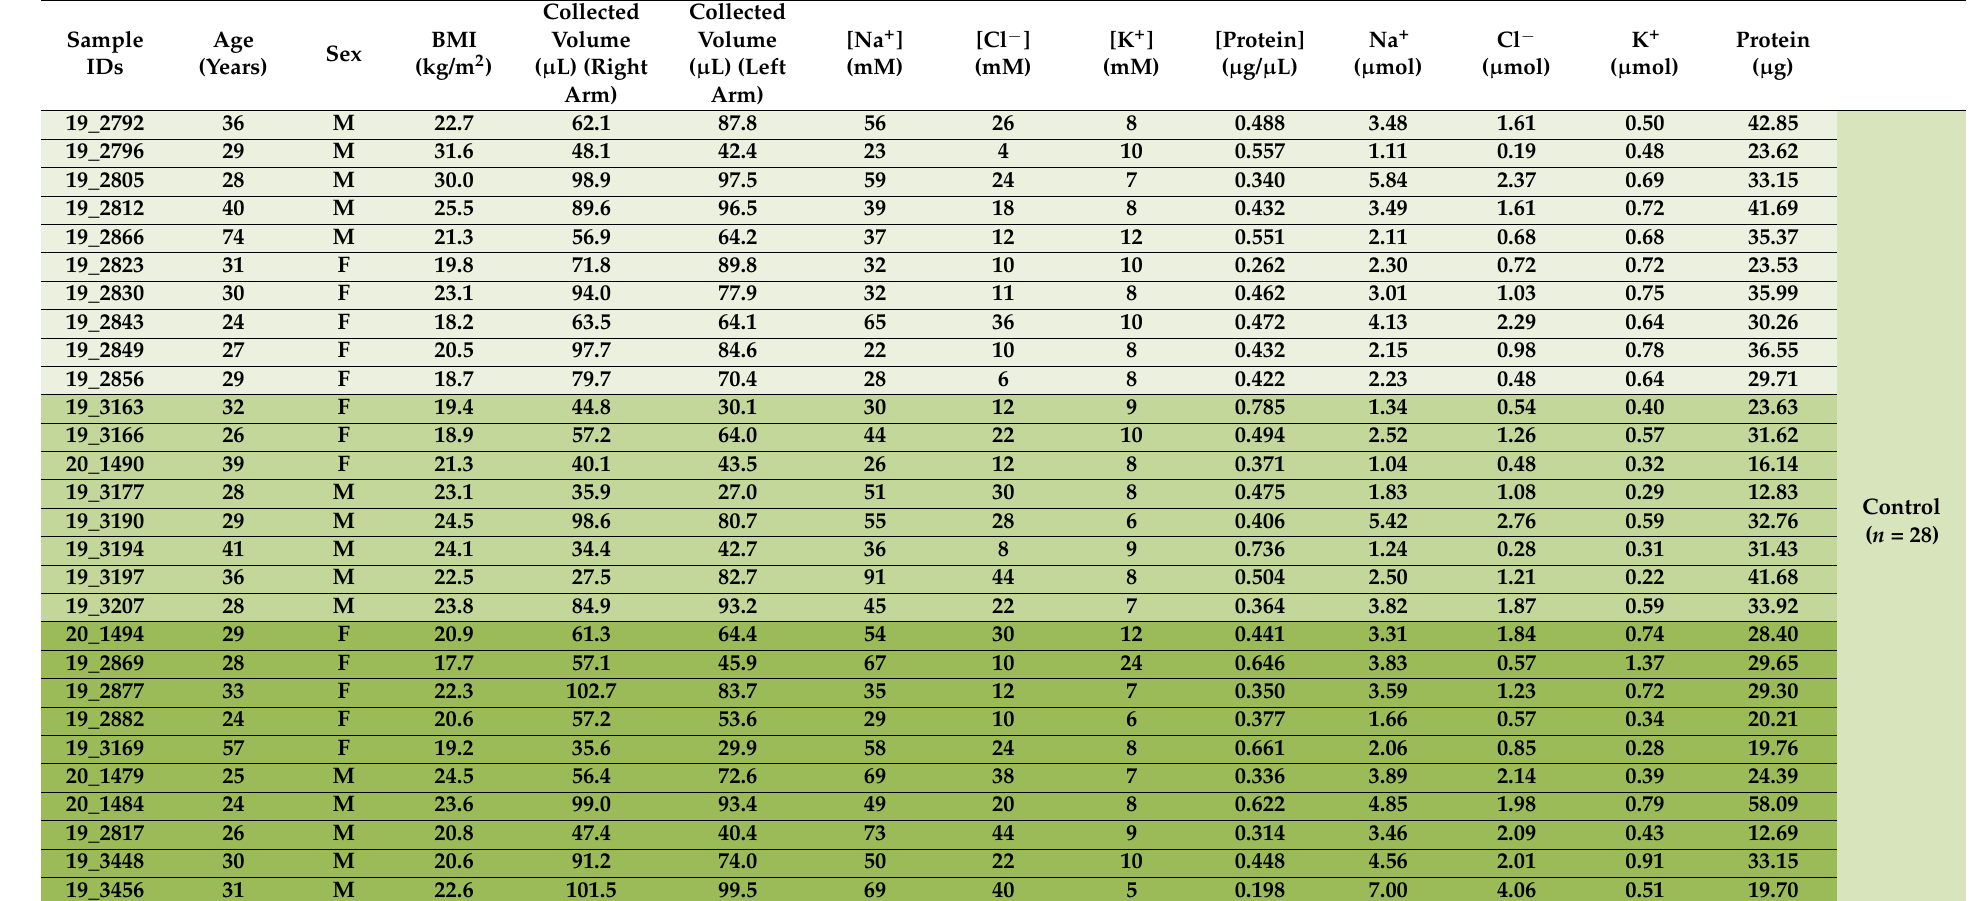
Table 1. Clinical data summary. Student’s t -test, significantly different parameters highlighted in green, p < 0.05 *, p < 0.01 **, p < 0.001 ***. Green (control) and red (CF) shades of background color indicated the different analytical